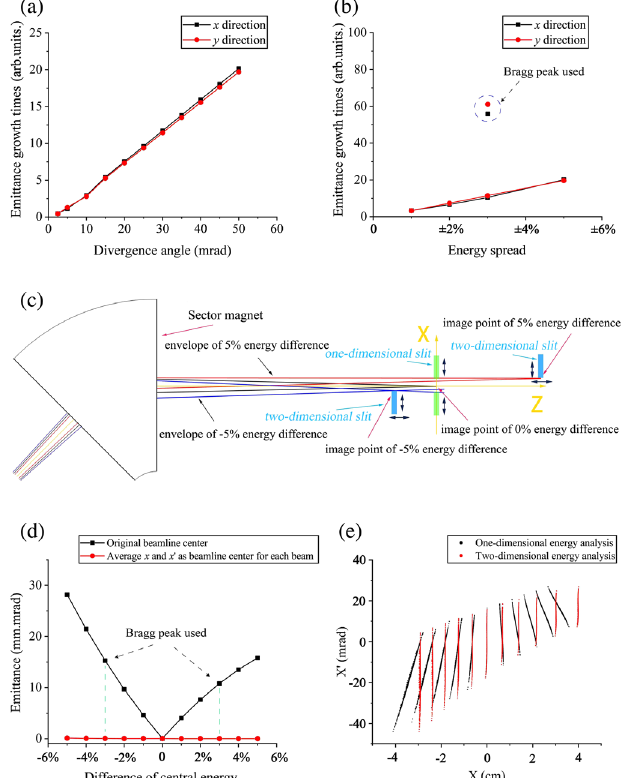
FIG. 4. Emittance growth under different conditions, and emittance with new beam line center. (a) Transverse emittance growth is approximately linear with divergence angle. The initial beam radius is 5 μ m and the energy spread is (cid:1) 1 %. (b) Transverse emittance growth is approximately linear with energy spread. The initial beam radius is 5 μ m and the initial divergence angle is (cid:1) 10 mrad. The initial divergence angle for dots circled in blue is (cid:1) 50 mrad, which is used in the production of the tailored energy distribution. (c) Schematic comparing selection with one- dimensional slit and two-dimensional slits. Black lines represent the envelope of protons at the central energy. Red and blue lines represent the envelopes of protons with þ 5 % and − 5 % energy difference respectively. These results are calculated using the program TRACK. (d) Emittance growth with and without adjust- ing the beam line center. Black dots show the normalized rms emittances of proton beams with different energy spreads. Red dots show new horizontal normalized rms emittance of each beam with a new beam line center determined by both the average position and the divergence angle. (e) Distributions of eleven monoenergetic proton beams in the horizontal ( x , x 0 ) phase space. The rightmost beam is the beam with 5% energy difference. Black dots show the results with one-dimensional energy analysis and red dots show the results with matching-image-point two- dimensional energy